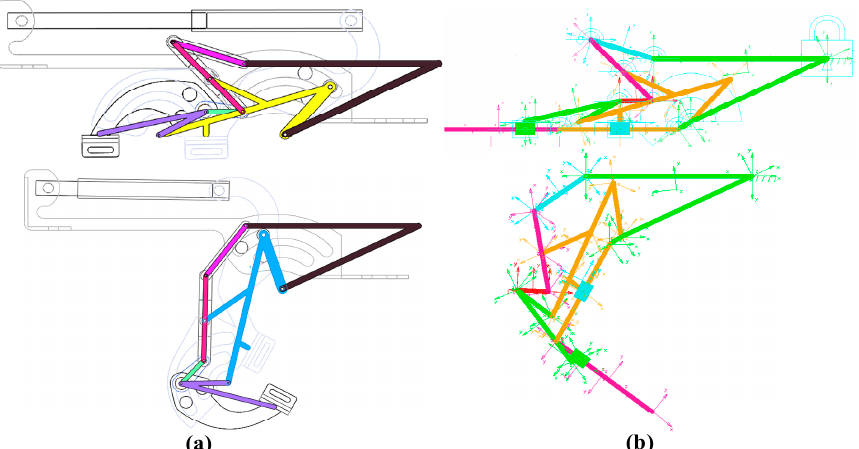
Figure 9. Simplified structure of finger part of hand rehabilitation robot. ( a ) The process of simplifying the model into connecting rod; ( b ) Establishment of simulation model of connecting rod.